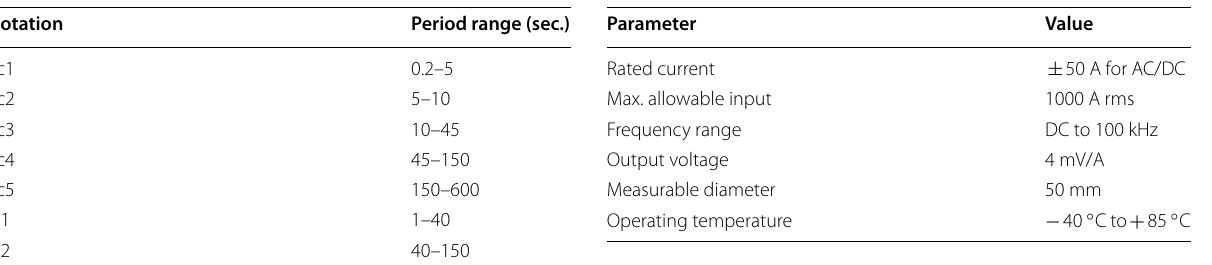
Table 1 Period ranges of pulsations of geomagnetic field